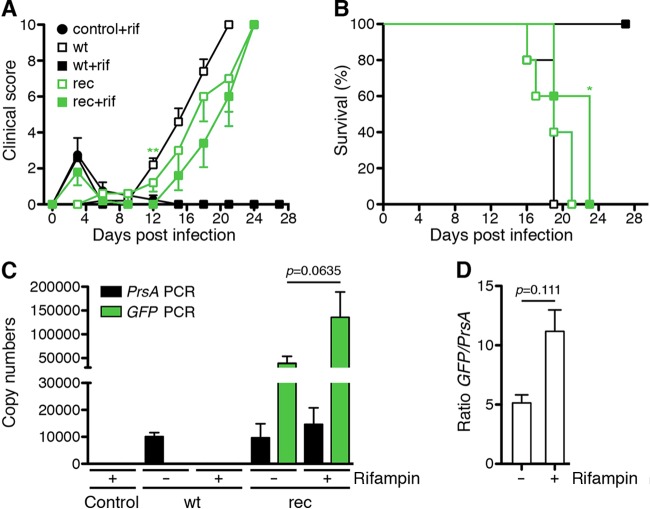
R. typhiGFPuv bacteria are as pathogenic as wild-type R. typhi
in vivo. (A) CB17 SCID mice (n = 5 for each group) were infected with 2 × 106 SFU of wild-type R. typhi (wt) or R. typhiGFPuv (rec). Control animals were not infected but received PBS. The animals were treated with rifampin (+rif) via drinking water or left untreated. The health status of the mice was monitored by a clinical score (y axis) at the indicated time points (x axis). The graph shows means ± standard errors of the mean (SEM). Statistical analysis was performed using a Mann-Whitney U test between mice infected with wild-type R. typhi without antibiotic treatment and rifampin-treated R. typhiGFPuv-infected animals. The asterisks indicate statistically significant differences (**, P < 0.01). (B) In addition, the survival rates were assessed. The survival rates of animals infected with wild-type R. typhi without antibiotic treatment and rifampin-treated R. typhiGFPuv-infected mice were compared using a log rank (Mantel-Cox) test. The asterisk indicates statistically significant differences (*, P < 0.05). (C) The bacterial loads in the spleens of the moribund animals described were determined by prsA-specific (black) and gfp-specific (green) qPCR. Organ samples from control mice and animals infected with wild-type R. typhi that were treated with rifampin and survived the infection were taken on day 30, when the experiment was terminated. The graph shows the means and SEM of the copy numbers (y axis) of the indicated groups of animals (x axis) (wt, wild-type R. typhi; rec, R. typhiGFPuv). (D) The ratio of gfp versus prsA copy numbers was determined for each mouse. The means and SEM of the ratio (y axis) in R. typhiGFPuv-infected CB17 SCID mice that were either untreated or received rifampin, as indicated on the x axis, are depicted. (C and D) Statistical analysis was performed using the Mann-Whitney U test between the indicated groups.